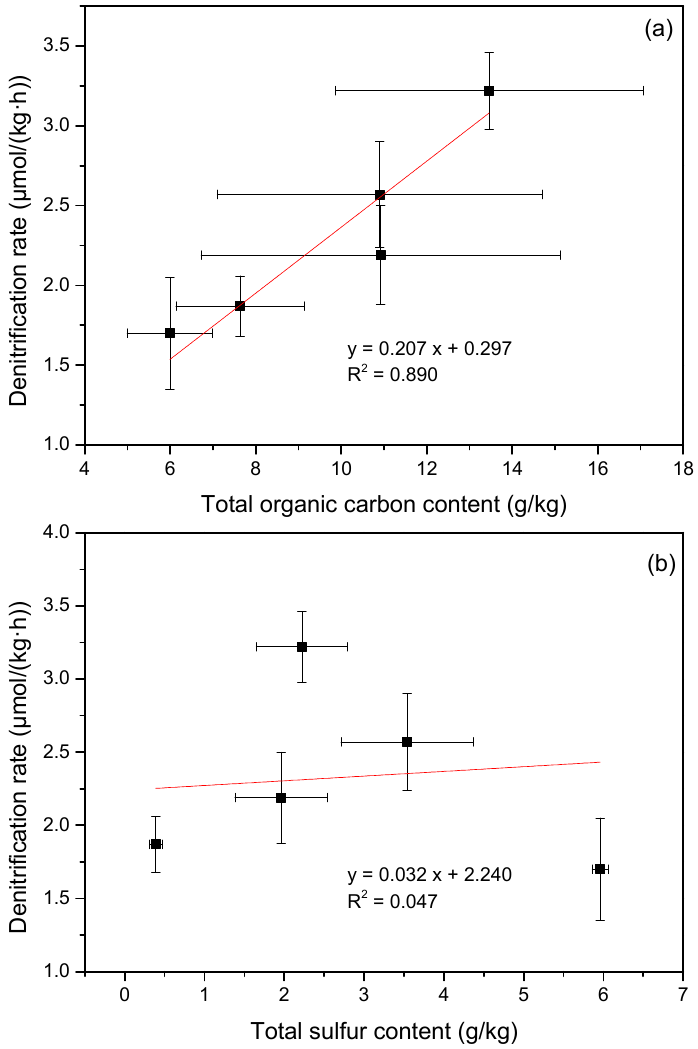
Figure 4. Fitting relationship between the denitrification rate and total organic carbon content ( a ) and total sulfur content ( b ).